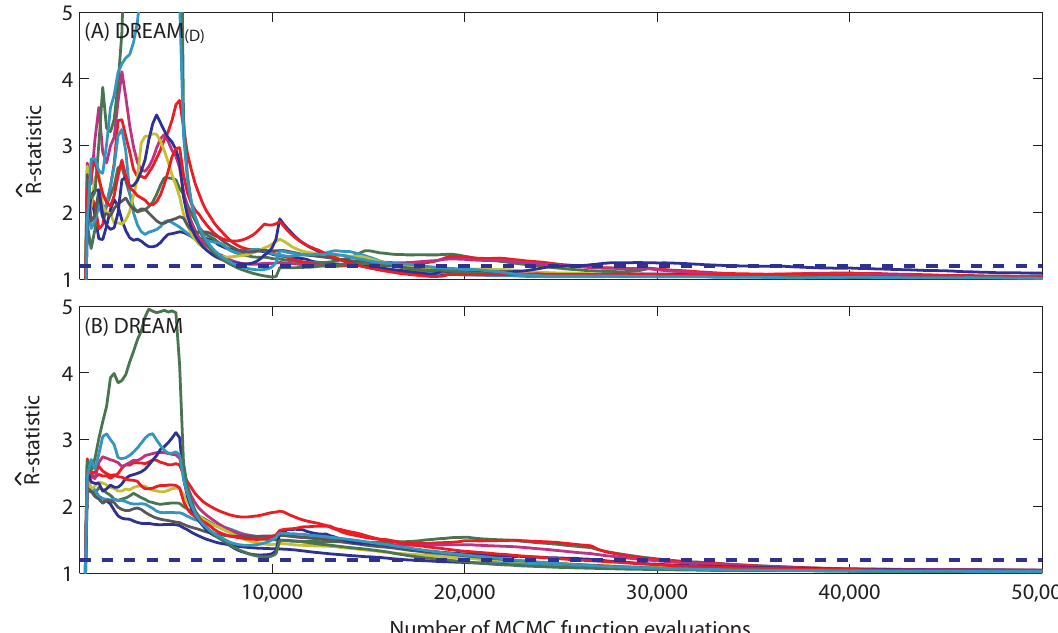
Fig. 9. Simulated traces of the ˆ R -statistic of Gelman and Rubin (Gelman and Rubin, 1992) using the (A) DREAM ( D ) (top panel)(discrete sampling), and (B) DREAM (bottom panel)(continuous sampling) MCMC algorithms. Each parameter is coded with a different color. A similar convergence speed is observed for both